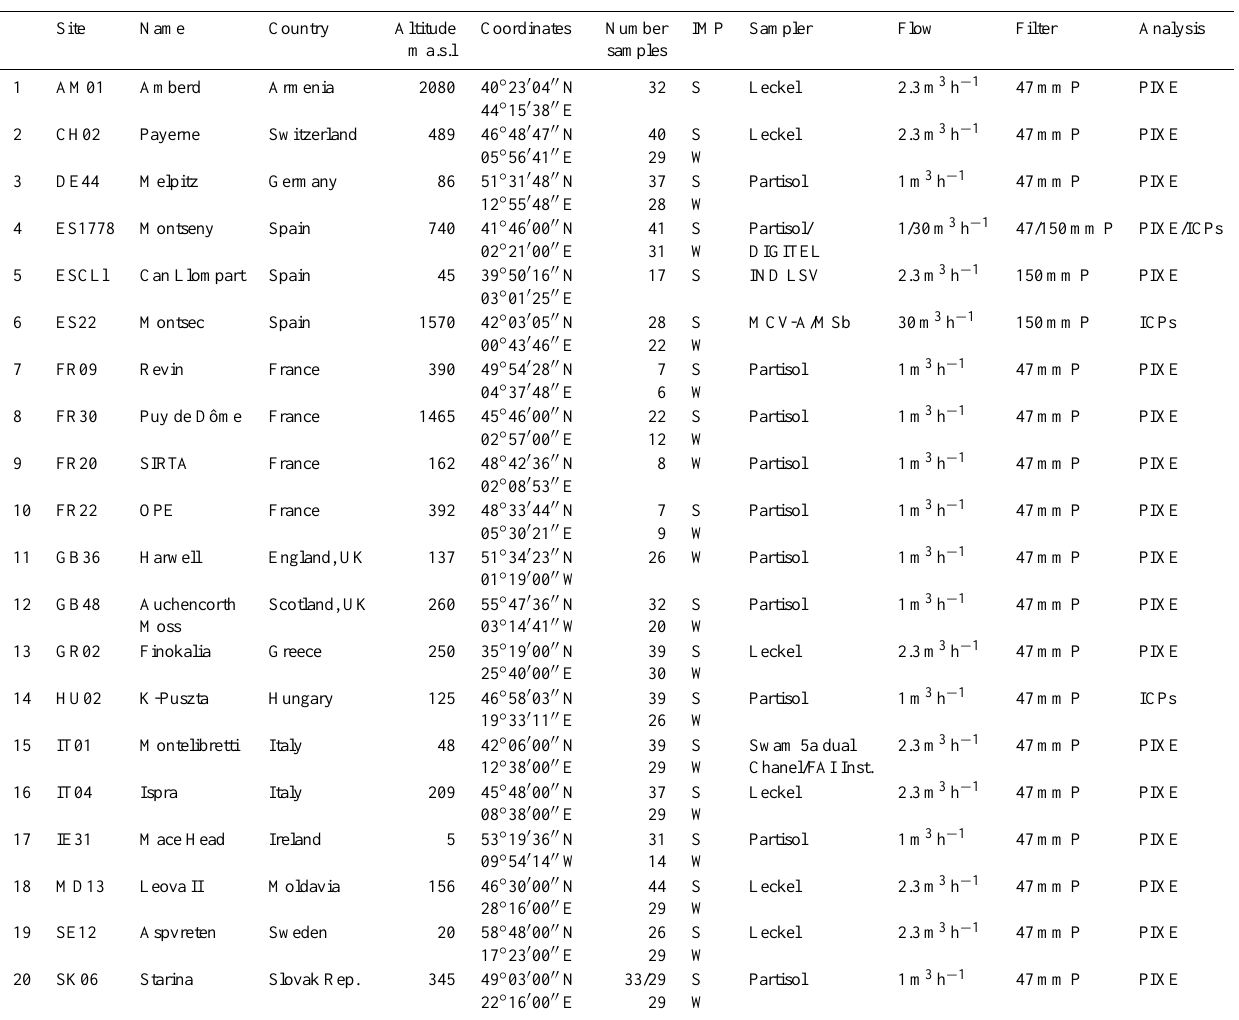
Figure 1. Location of the sampling sites participating in the EMEP IMPs in summer 2012 and/or winter 2013. Blue symbols: northern Europe; purple symbols: central western Europe; black symbols: central Europe; green symbols: eastern Europe; red symbols: south-western and central southern Europe; yellow symbols: south-eastern Europe; empty symbols: mountain sites. Table 1. Sampling sites participating in the 2012–2013 IMP. S: summer IMP; W: winter IMP. P: